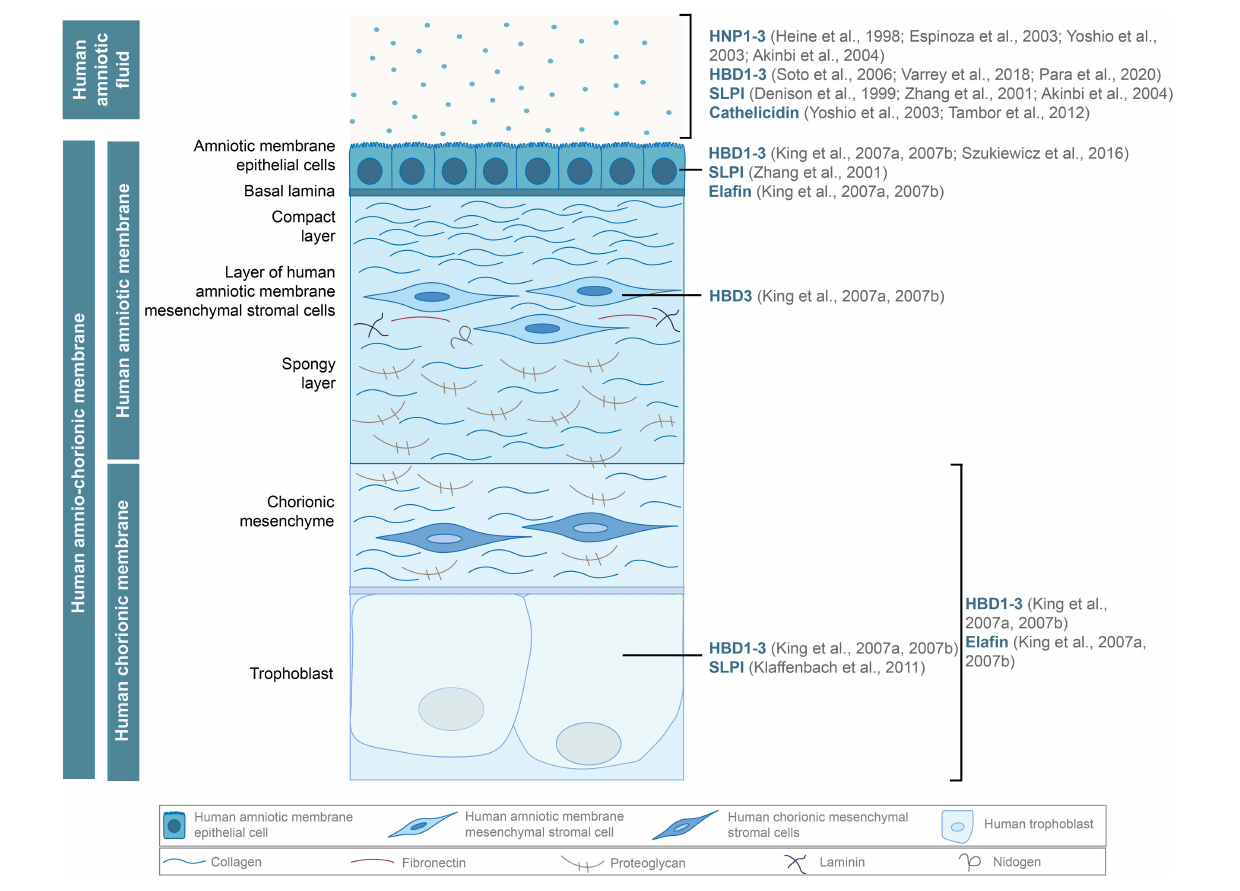
FIGURE 1 | Antimicrobial peptides, such as human α (HNP1-3) and β -defensins (HBD1-3), cathelicidin, and proteases of the WFDC family (SLPI, elafin), are secreted by the hAM and hCM cells and found in the hAF. Adapted from Cirman et al.